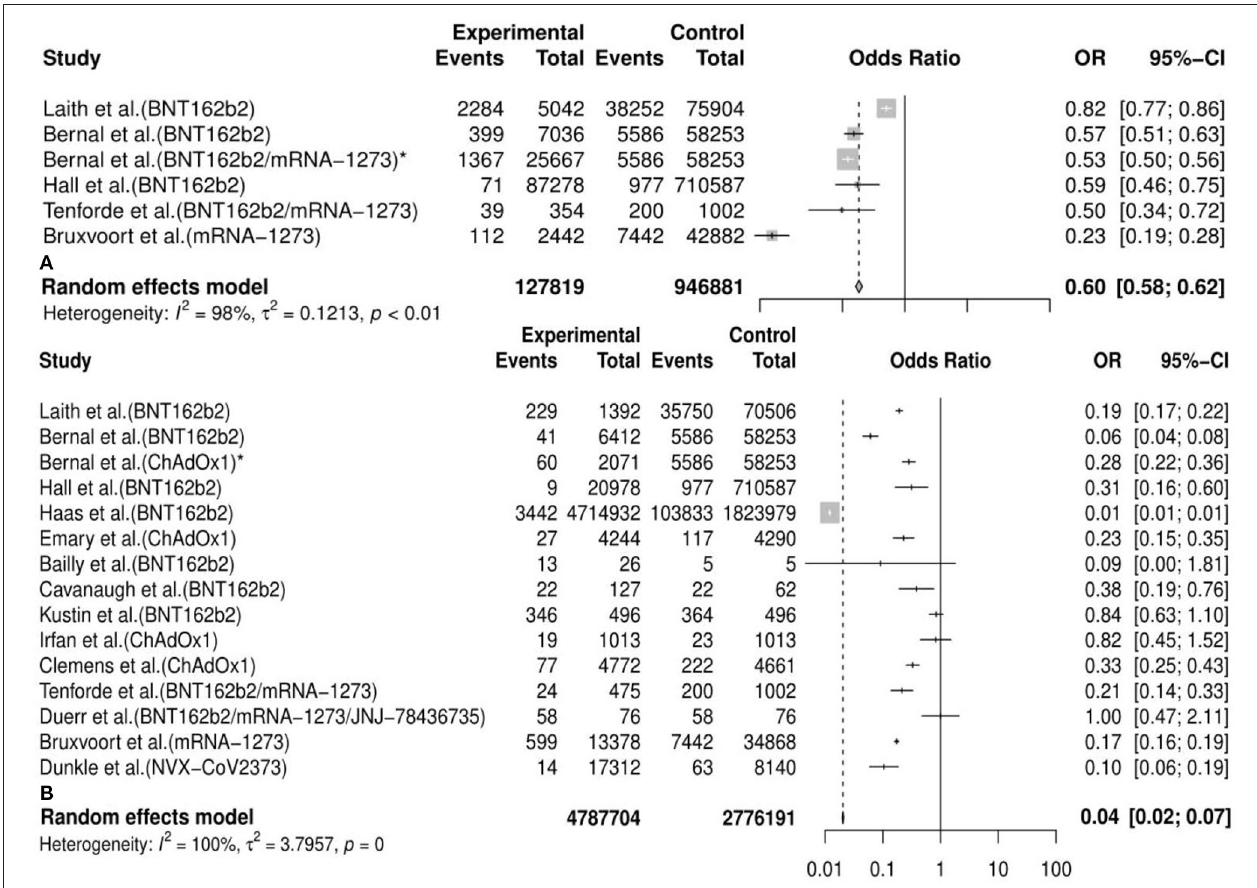
FIGURE 3 | Meta-analysis for the overall efficacy of vaccines against COVID-19 variants post first vaccine (A) and post second vaccine (B) . * indicates the second arm in the study of Bernal et al. CI. confidence interval; OR, odds ratio.